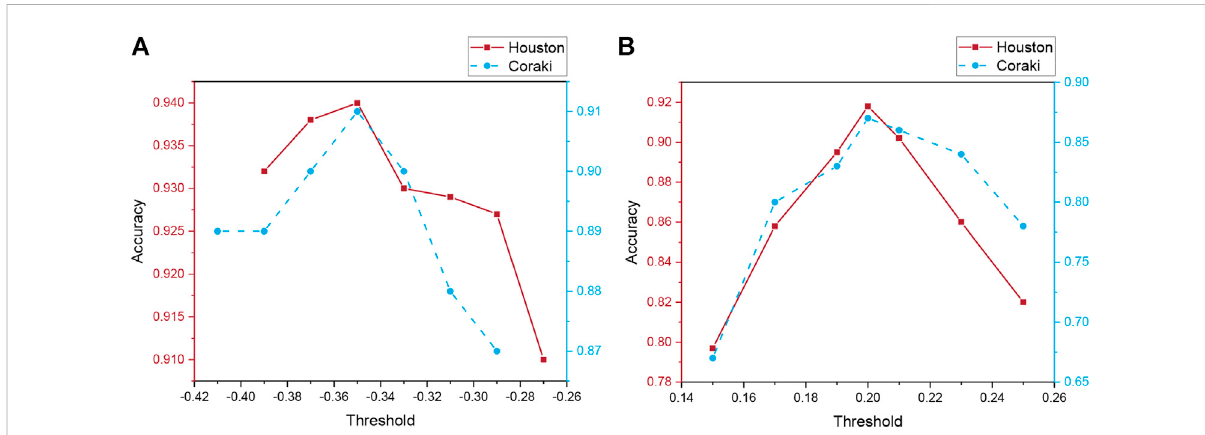
FIGURE 4 SegmentationaccuracyatDBAandNDBAintheHoustonandCoraki: (A) fl oodsegmentationaccuracyatdifferentsegmentationthresholdsfor DBA; (B) NDBA fl ood segmentation accuracy at different segmentation thresholds.